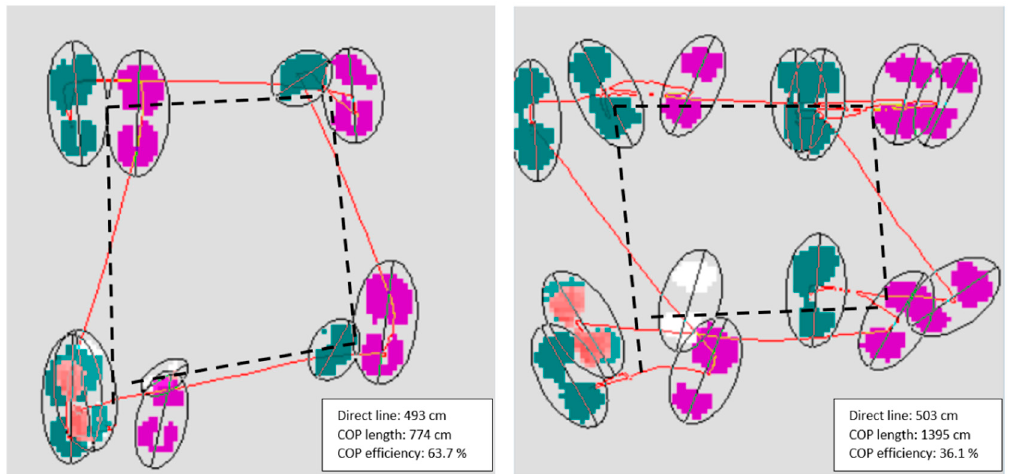
Figure 2. Illustration of the distances used for the computation of the global center of pressure (COP) efficiency, for a good ( left ) and a bad ratio ( right ). The red line represents the COP pathway and the black line represents the distances between the middle of each couple of footprints in successive squares. The displays only show the first four couples of footprints.